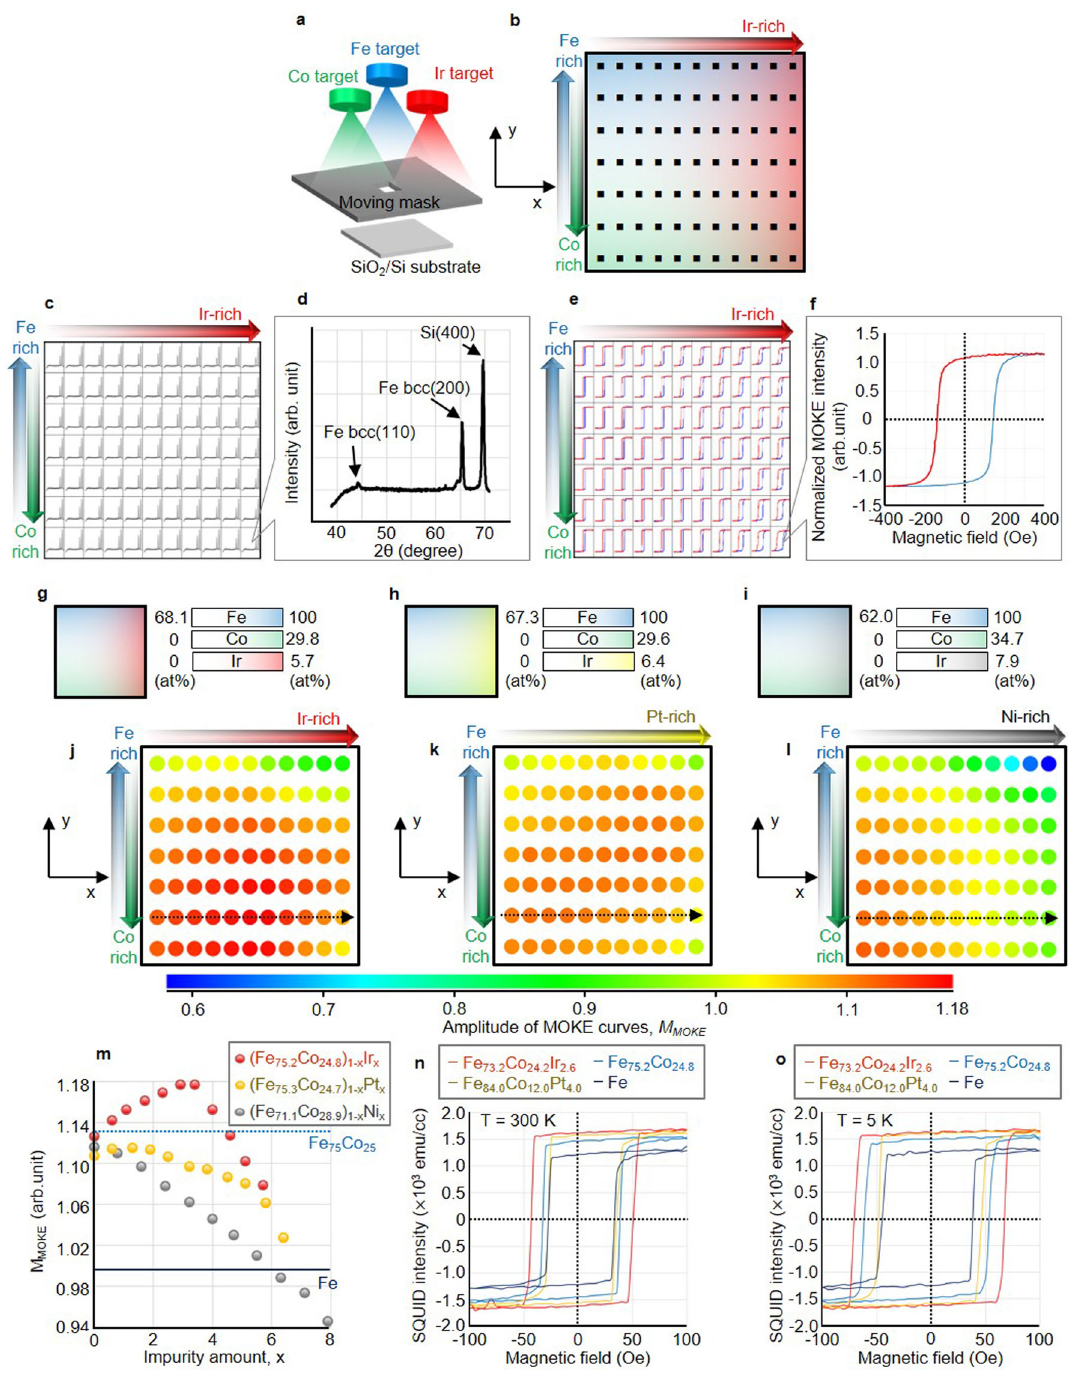
Fe x Co y Ir 100-x-y , Fe x Co y Pt 100-x-y , and Fe x Co y Ni 100-x-y , respec- tively. Small amounts of Ir and Pt impurities enhance mag- netic moment in Fe x Co y Ir 100-x-y and Fe x Co y Pt 100-x-y systems. On the other hand, increasing amounts of Ni monotonically decrease magnetic moment in the Fe x Co y Ni 100-x-y system. These results are consistent with the results of MOKE and SQUID